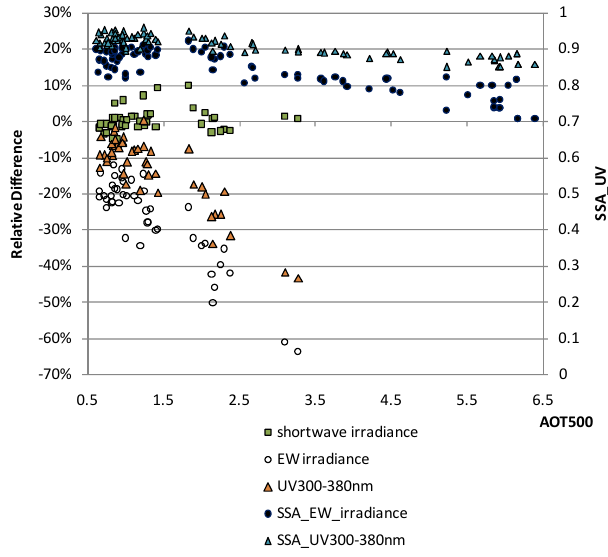
Fig. 11. Comparisons between measurements and modelling (Rel- Fig.11.Comparisons between measurements and modelling ( Relative Difference=Measurement/Modelling ‐ 1,%) for shortwave irradiance , UV300 ‐ 380nm and EW irradiance ative Difference = Measurement/Modelling-1,%) for shortwave ir- (left axis) and the retrievals of SSA for EW irradiance and UV300 ‐ 380nm (right axis). See the details in radiance, UV300–380nm and EW irradiance (left axis) and the re- the text. trievals of SSA for EW irradiance and UV300–380nm (right axis). See the details in the text.